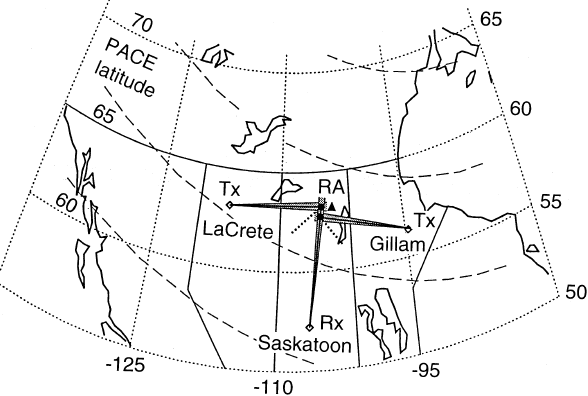
Fig. 1. The geometry of the experiment. Two transmitters were located at LaCrete and Gillam, two receivers at Saskatoon. Invariant latitudes according to the Polar Anglo-American Conjugate Exper- iment (PACE) coordinate system (Baker and Wing, 1989) are shown by dashed lines . The link bisectors are marked by thick dotted line . Black triangle is the location of Rabbit Lake (RA) magnetometer